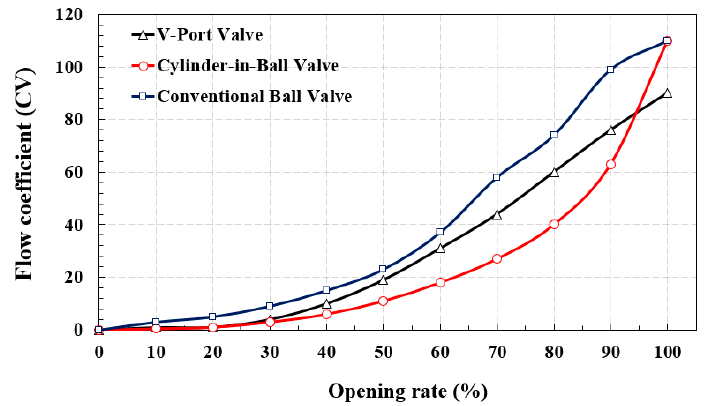
Figure 6. The CV values to opening rates for the cylinder-in-ball valve, conventional ball valve, and V-port ball valve.